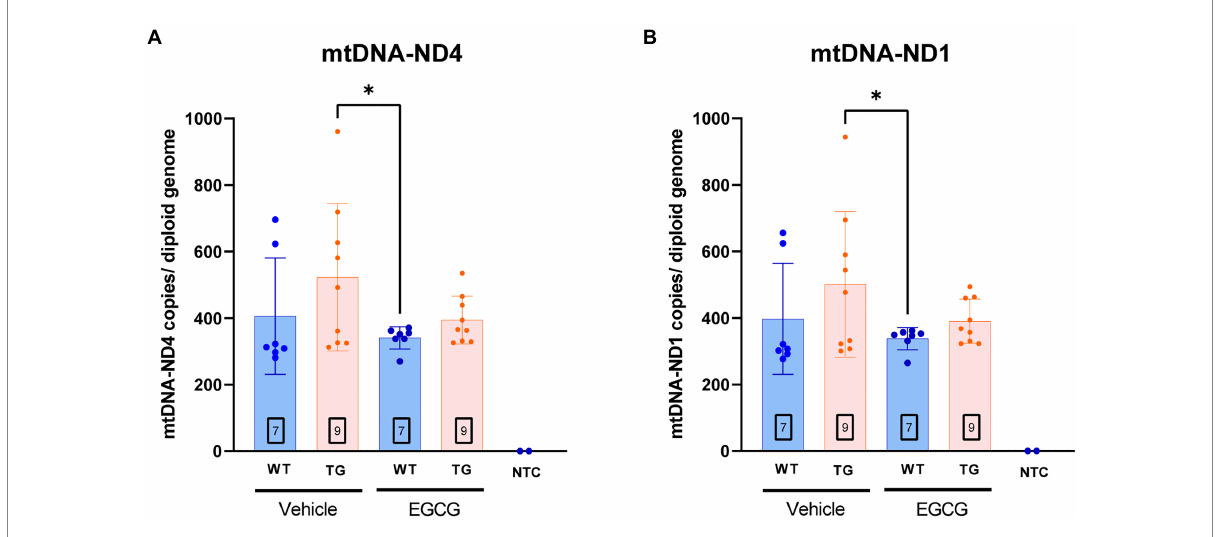
FIGURE 5 mtDNA copy number per cell is increased in TG mice. mtDNA copy number per cell in the Declive neuron-rich area of the cerebellum. Quantification of mitochondrial DNA copy number per diploid genome was performed with a multiplex digital PCR with different primer pairs targeting opposed regions of the mtDNA sequence: (A) the ND4 coding region and (B) the ND1 region. The n number of animals is within squares. Results are expressed as mean ± SD. * p <